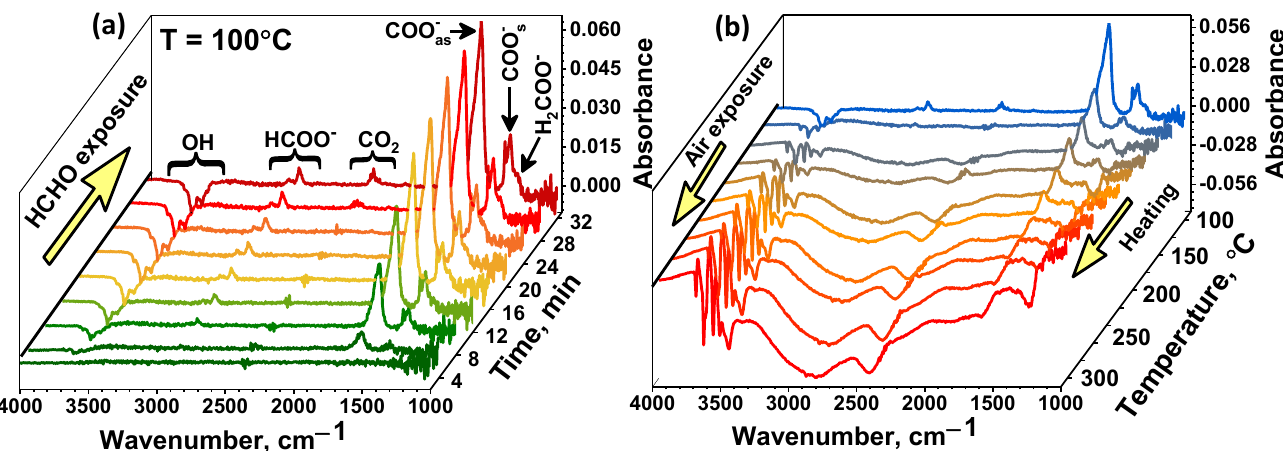
Figure 10. In situ DRIFT spectra of the SnO 2 /TiO 2 @Pt sample during HCHO adsorption at T = 100 °C ( a ) and during heating in air atmosphere after HCHO adsorption ( b ).